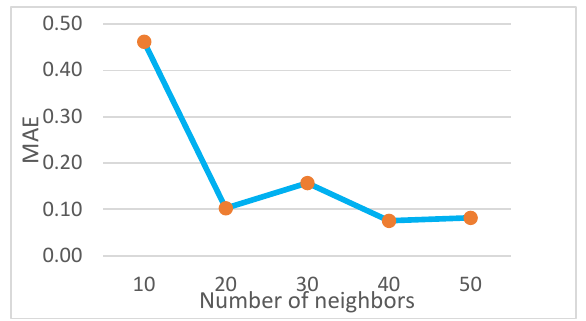
Figure 2. Impact of the neighborhood size.